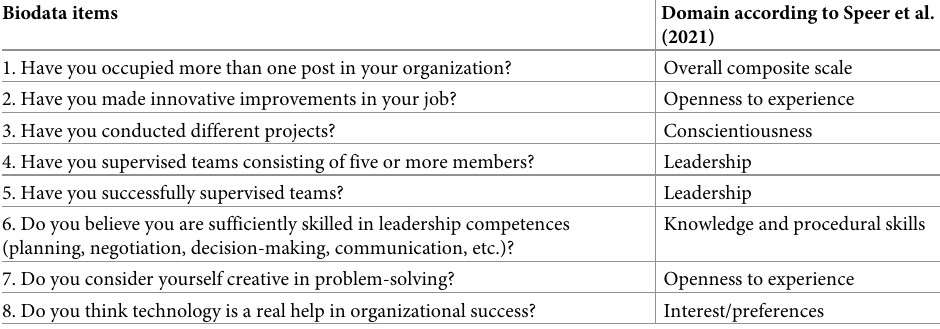
Table 1. Biodata items and domains to which they